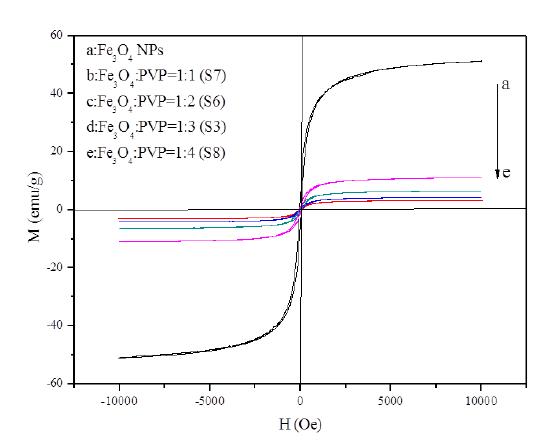
O NPs (a) and PANI/Fe 3 4 O to PVP (b, c, d and e) 3 4 O NPs and PANI/Fe 3 4